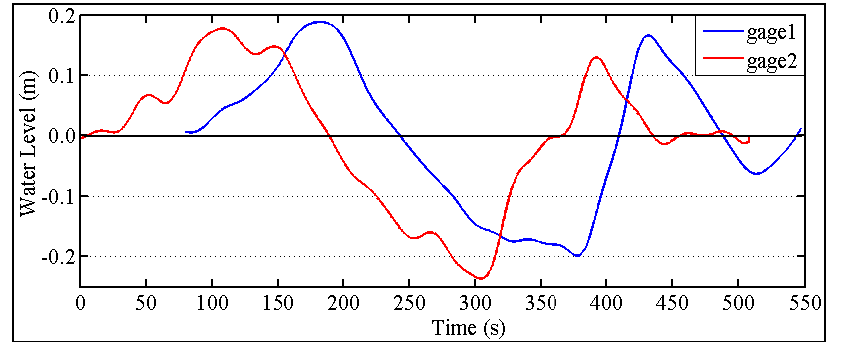
Figure 6. The low-pass filtered long waves measured at the two nearshore locations. The measurement locations are shown in Figure 1D. Table 1. Comparison among measured and calculated wave speeds.